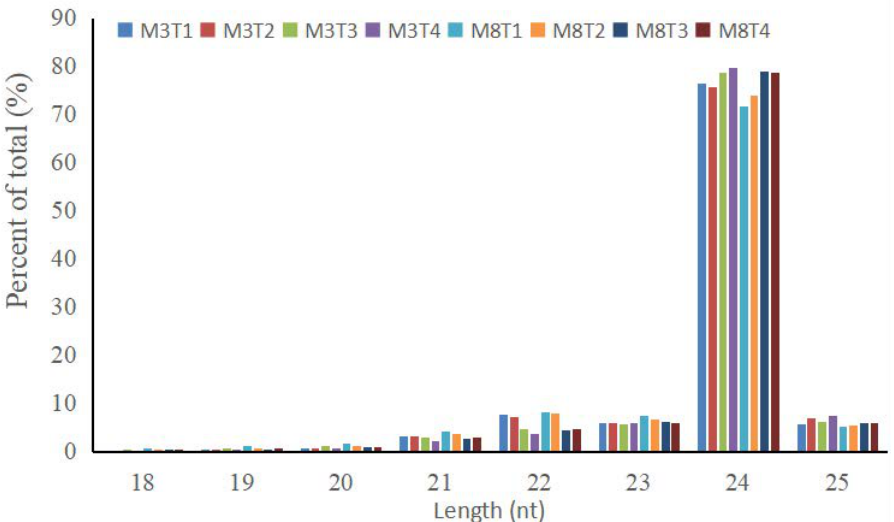
Figure 1. Length distributions of unique miRNAs from the seeds of the ‘M3’ and ‘M8’ cultivars of tea oil camellia at four different developmental